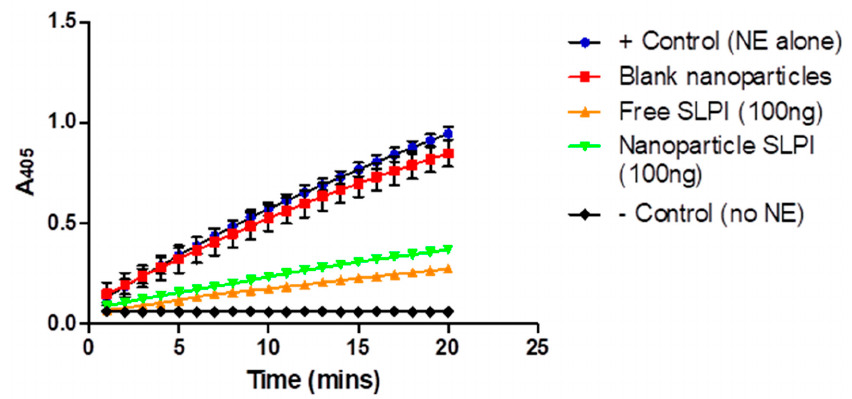
Figure 3. Inhibition of neutrophil elastase (NE) by secretory leukocyte protease inhibitor (SLPI)-conjugated particles. Results presented as mean ± S.D, N = 3.